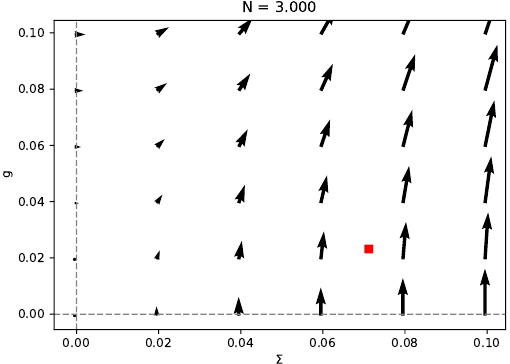
Figure 2: Graphical representation of the scheme change between the POS and MS scheme: we plot the singlet moment against the gluon moment at N = 3. The ar- rows indicate the shift of moments that the scheme change imposes. The red square denotes the reference value for the NNPDF3.1 PDF set [ 2 ]